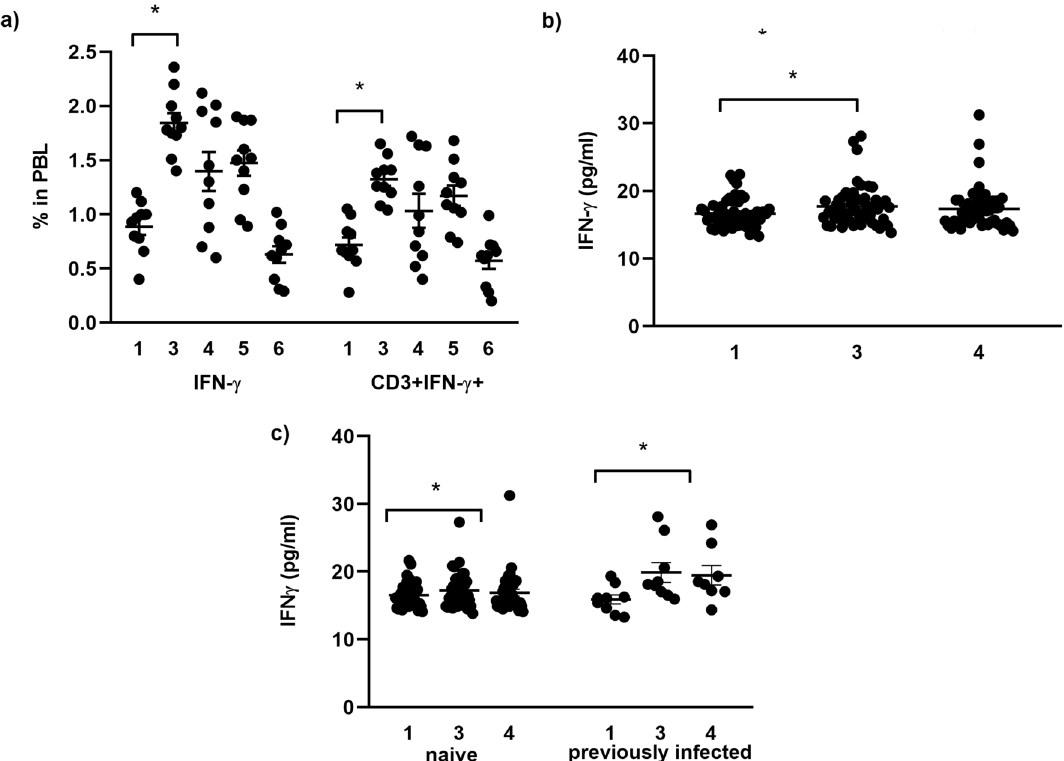
Figure 3. ( a ) Expression of IFN-γ in all and CD3 + T peripheral blood lymphocytes. Serum level of IFN-γ in the ( b ) whole analyzed group, ( c ) naïve and previously infected individuals. The results are presented as individual values with mean ± standard error of the mean (SEM). Differences between values were compared using Wilcoxon signed-rank test and the results were considered statistically significant if p < 0.05. * p <